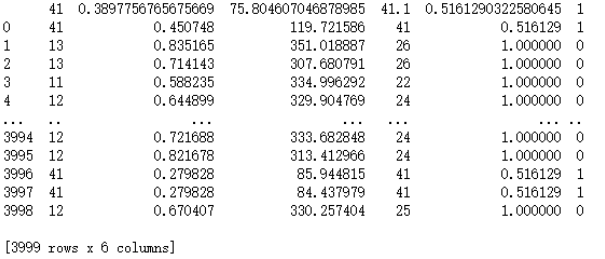
Figure 6. Print of the overall environment-specific dataset over normal or DDoS